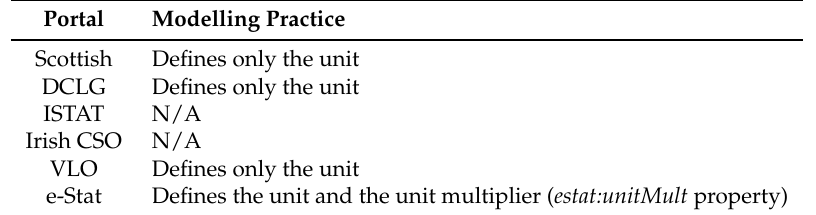
Table 23. Distinct modelling practices of data portals regarding the number of measures.